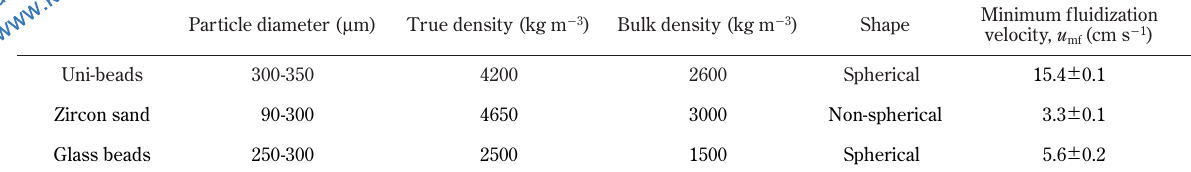
Note: Averaged values and standard deviations of u mf were obtained from three measurements.